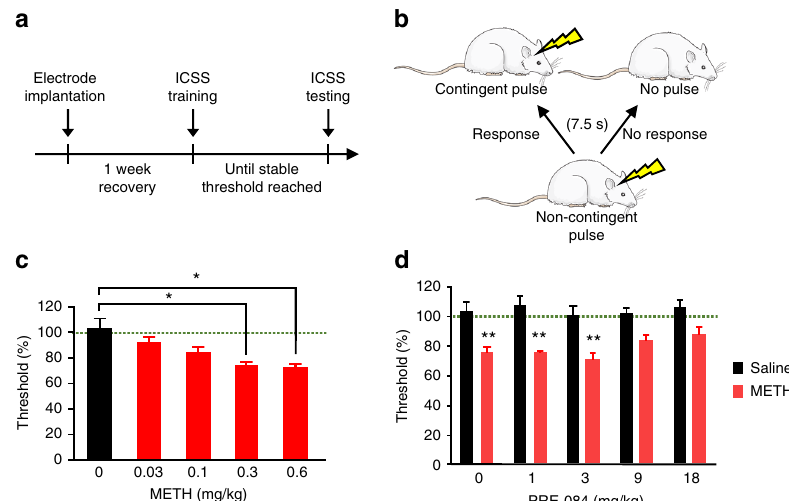
Fig. 7 σ 1 R activation decreases the effects of METH on reward thresholds. a Experimental timeline for intracranial self-stimulation (ICSS) experiments is shown. b Schematic demonstrating ICSS testing is shown. Rodents receive a non-contingent pulse at a given frequency and are given 7.5 s to respond. Positive responding by the rodents results in a contingent pulse at the same frequency as the non-contingent pulse. The reward threshold is de fi ned as the minimal frequency required to elicit a response. Rat image is courtesy of Servier Medical Art, licensed under CC BY 3.0 (https://creativecommons.org/ licenses/by/3.0/legalcode). c The dose – response studies revealed METH dose-dependently lowers brain rewards thresholds in rats as measured via ICSS. Data is presented as percent vehicle control ( n = 8 rats; F (7, 28) = 3.479, P = 0.0083, repeated measures one-way ANOVA; Dunnett ’ s test for multiple comparisons against control, * P < 0.05). d PRE-084 treatment attenuated the METH-induced (0.3 mg/kg) decrease in brain reward thresholds ( n = 6 saline rats, 8 METH rats; F (1,12) = 75.23, P < 0.0001, two-way ANOVA; Bonferroni ’ s test for multiple comparisons, ** P < 0.01 saline vs. METH; + P < 0.05 indicates a higher brain threshold compared to METH and 3 mg/kg of PRE-084). Data is represented as mean ±